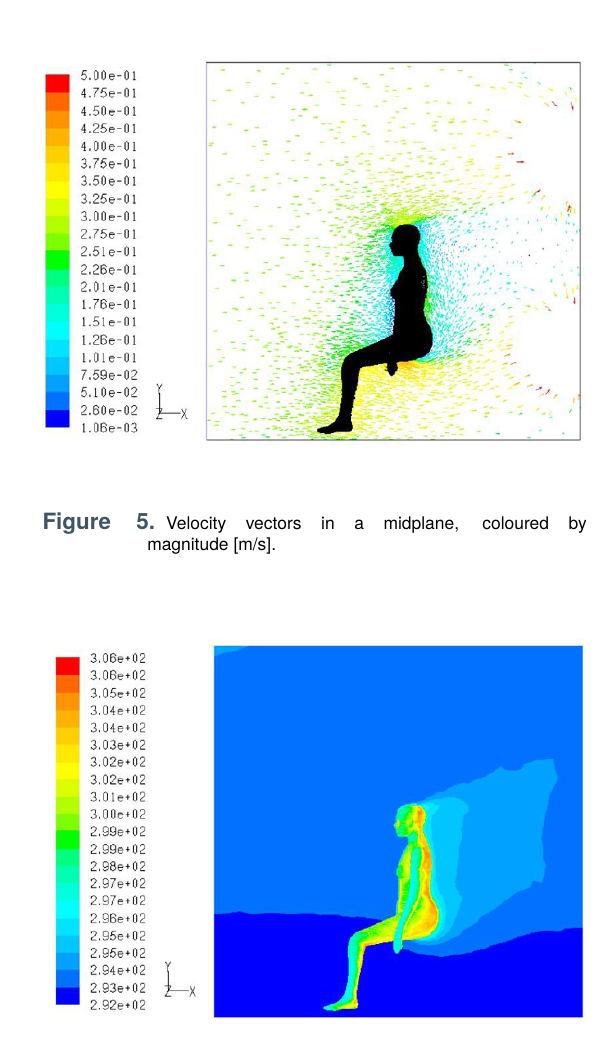
Figure 6. Temperature field in the midplane